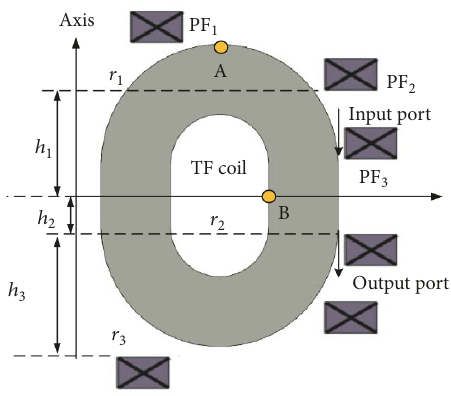
Figure 7: The position of PF coils and TF